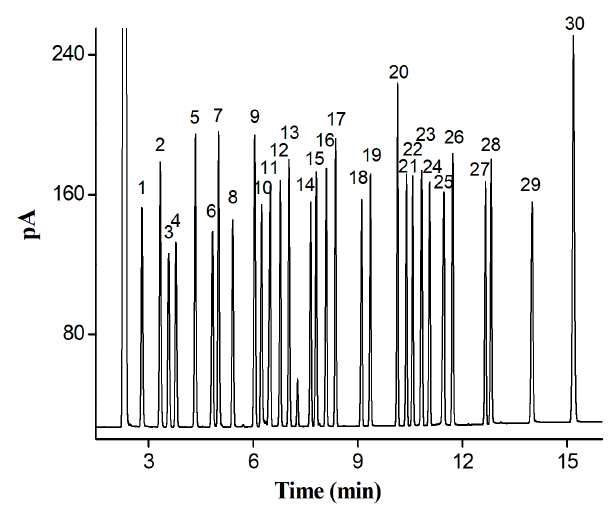
Figure 2. Separations of the complex mixture of 30 analytes of diverse types on the PCL-PEG-PCL column. Peaks: (1) n -nonane, (2) toluene, (3) 1-bromopentane, (4) 2-hexanone, (5) ethylenzene, (6) 1-bromohexane, (7) 2-propylbenzene, (8) 1-pentanol, (9) sec -butylbenzene, (10) 1-bromoheptane, (11)